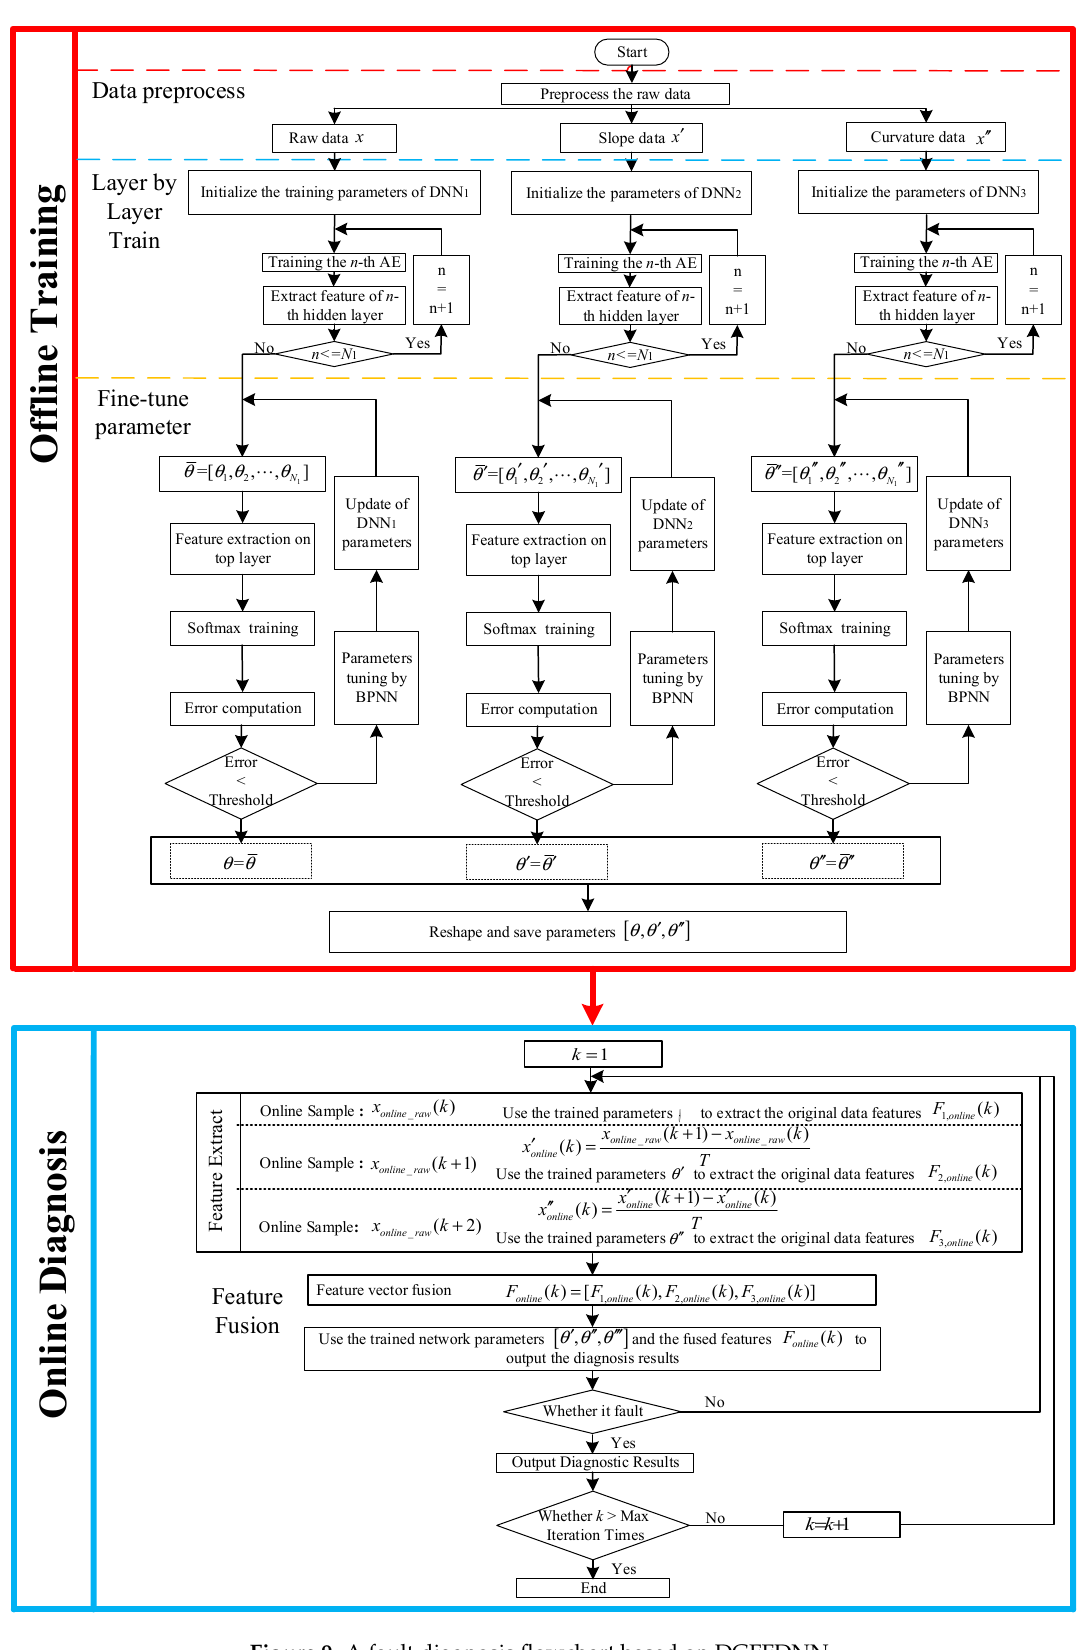
Figure 9. A fault diagnosis flowchart based on DGFFDNN.